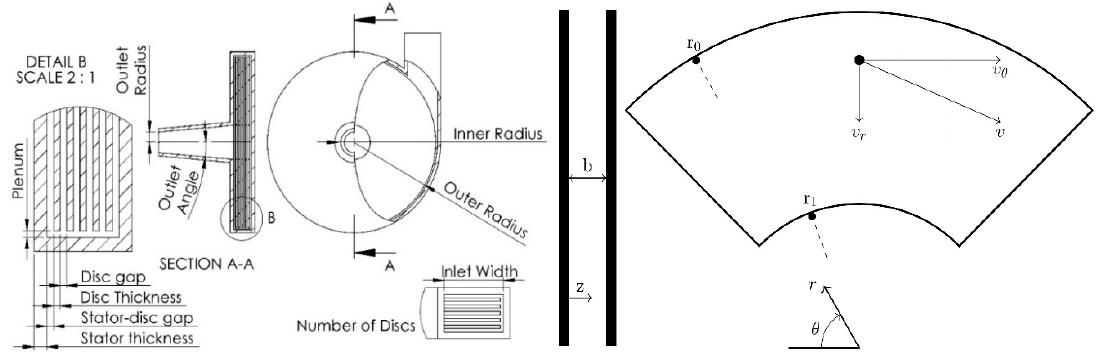
Figure 1. ( left ): Drawing of a Tesla turbine (TT) geometry and definition of its different parts. ( right ): Coordinate system and some dynamic variables.